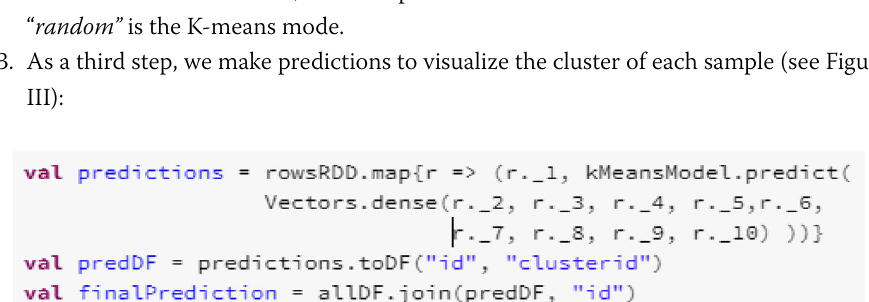
Figure II Implementation of Kmeans model